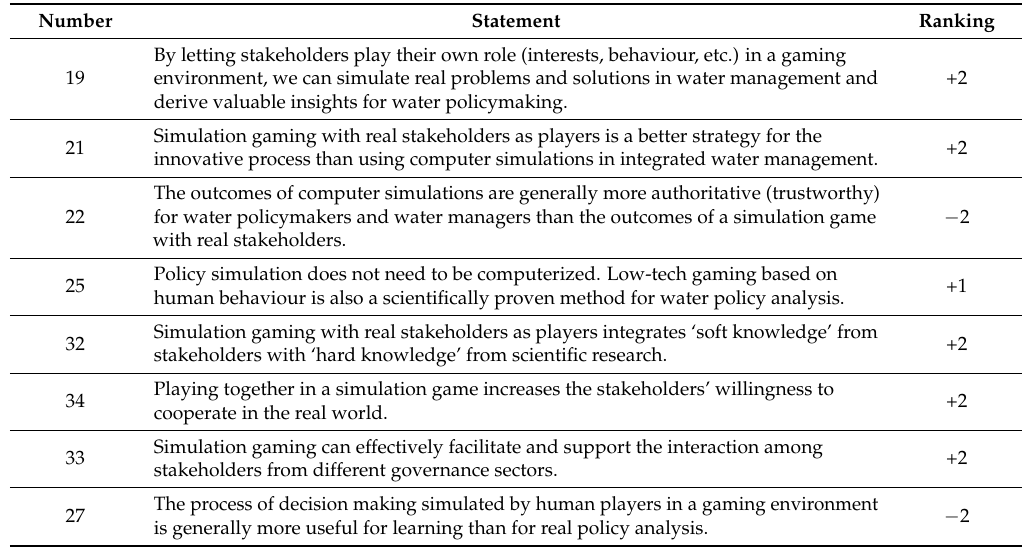
Table 16. Distinguished statements about MSG in frame